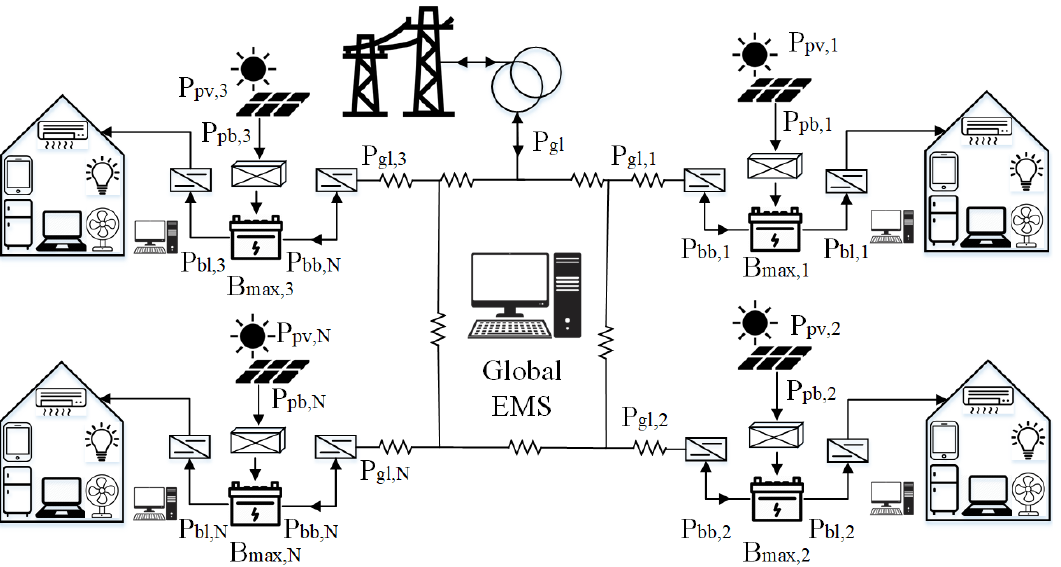
Figure 4. A schematic diagram of interconnected multi-microgrid system showing power flow between different DERs and